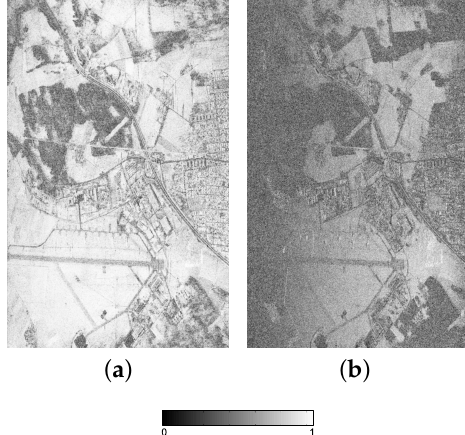
Figure 11. Example of interferometric coherence for ( a ) a small and ( b ) a large baseline, helping the interpretation of the Wishart classification results for TomoSAR CM. On the one hand, the coherence is an informative feature for TomoSAR CM classification. On the other hand, baseline decorrelation provokes a strong loss of coherence, especially in the near range. The Wishart classifier is sensitive to this effect due to its unimodal assumption whereas RF can handle this